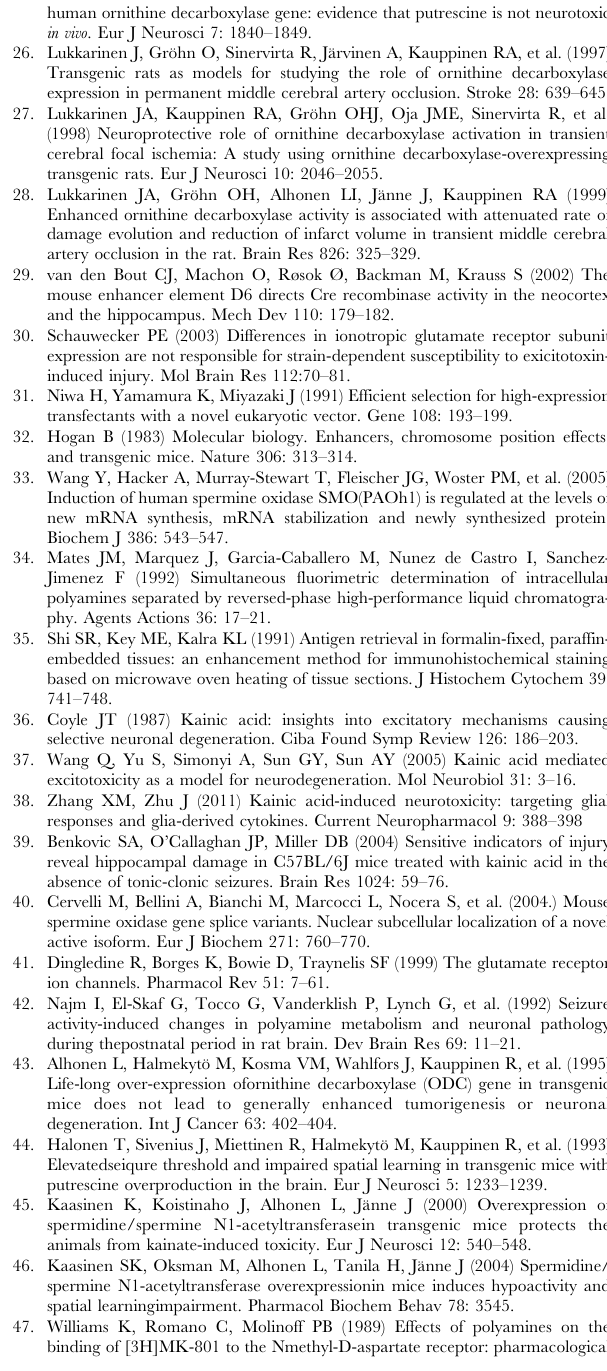
Figure S1 Immunohystochemical analysis of neocortex from Sg and WT mice. Sagittal brain slices from WT and Sg mice were stained with antibodies directed against SMO, NeuN, GFAP and Iba1. Slides of neocortex from 12 months old mice were analyzed. Cell counting is expressed as number of